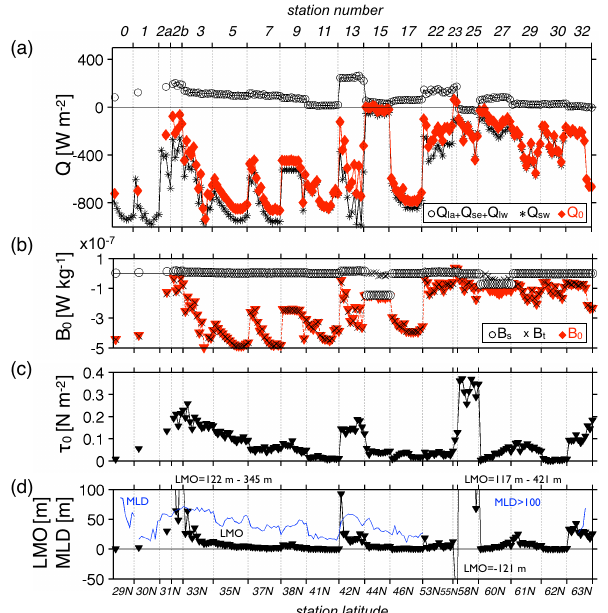
Fig. 2. Meteorological data averaged over the time of each SCAMP profile: (a) net surface heat flux Q 0 and related components (latent heat flux Q la , sensible heat flux Q se , net long-wave heat flux Q lw , short-wave radiation flux Q sw ); (b) net surface buoyancy flux B 0 and related components (thermal surface buoyancy flux B t , haline surface buoyancy flux B s ); (c) surface wind stress τ 0 ; (d) Monin– Obukhov length (LMO), and mixed layer depth (MLD). Q 0 is de- fined positive upward and hence for B 0 < 0 the buoyancy flux is stabilizing. Each marker represents a profile, and each dotted verti- cal line indicates the last profile of each sampling station. The num- ber of the corresponding station is shown at the top of the figure. A malfunction of the anemometer occurred at the stations 0 , 1 , and 2a , resulting in a lack of the derived τ 0 and LMO. Stations 22 to 30 had MLDs deeper than 250m. The MLDs depicted for the stations 0 , 1 , 11 , 17 , and 32 have to be treated with caution because they were not clearly defined from the temperature